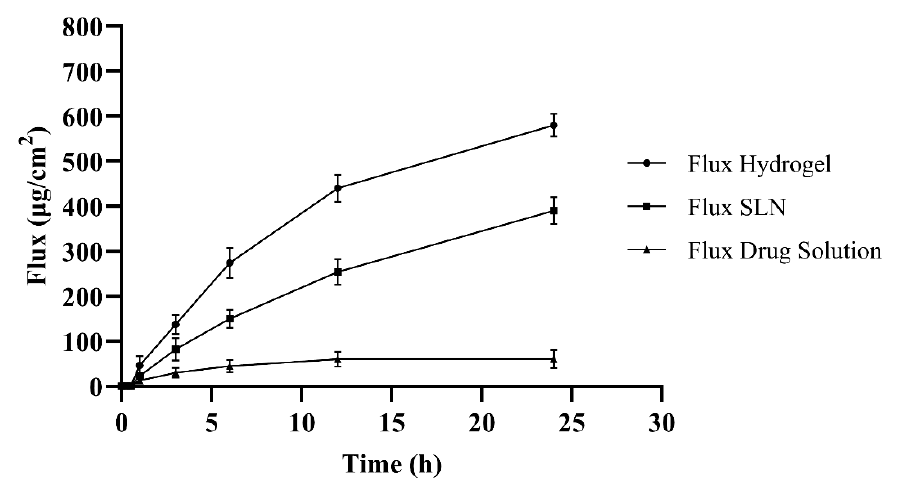
Figure 6. Ex vivo permeability studies of drug solution (control), SLNs and transdermal hydrogel at pH 7.4.